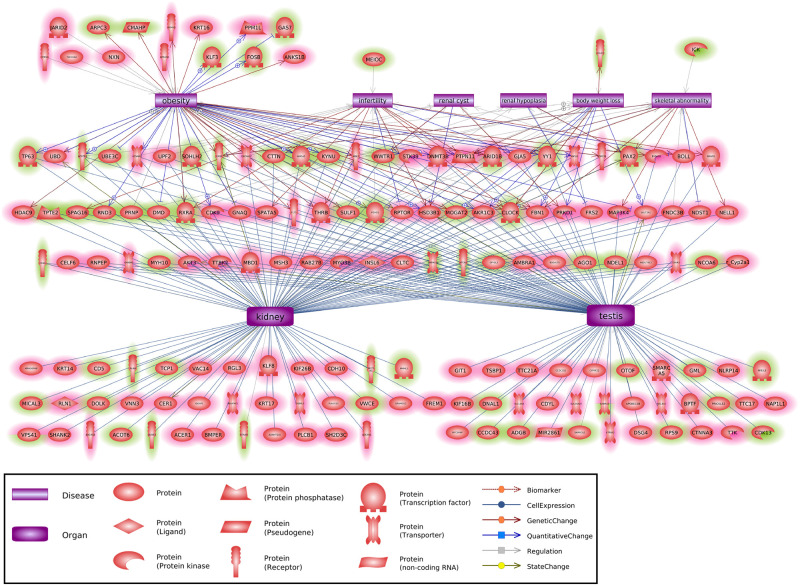
Multiple disease associated previously identified disease genes.The disease categories and gene identified shapes are presented. The green shading represents DMRs and pink shading DHRs.